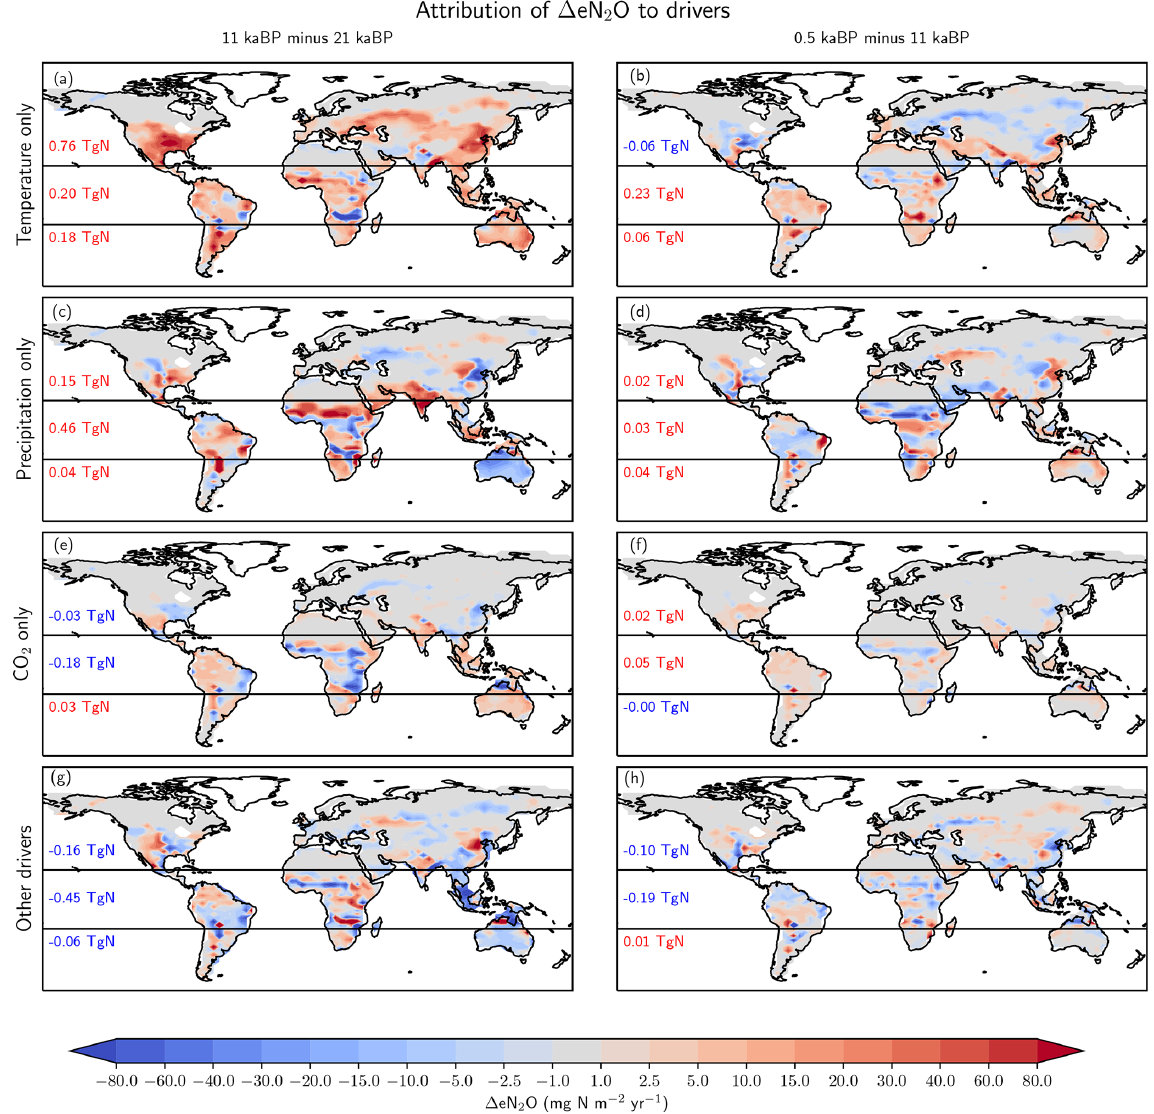
Figure 8. Attribution of simulated global terrestrial N 2 O emission changes to individual drivers for the last glacial termination (11ka minus 21ka; left) and the Holocene (0.5ka minus 11ka; right). Changes are attributed to changes in temperature (a, b) , precipitation (c, d) , atmospheric CO 2 (e, f) , and non-linear interactions among the drivers plus the small effect due to changes in incident solar radiation (g, h)